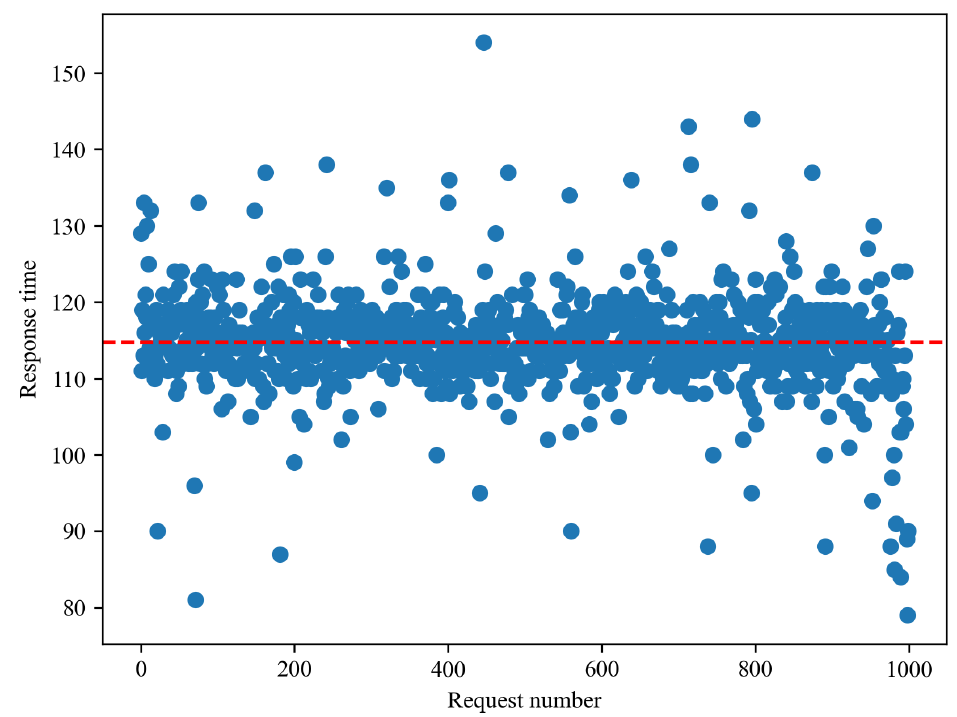
Figure 4. Response times for 1000 requests using random